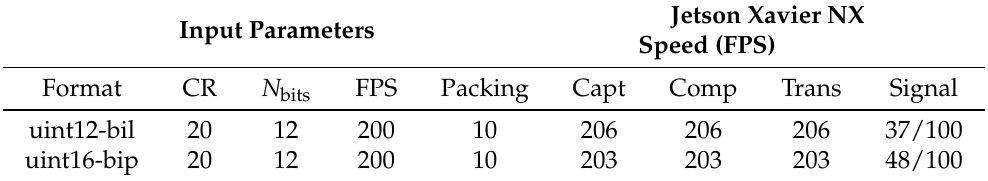
Table 7. Speed results for the proposed design when increasing the packing size to 10